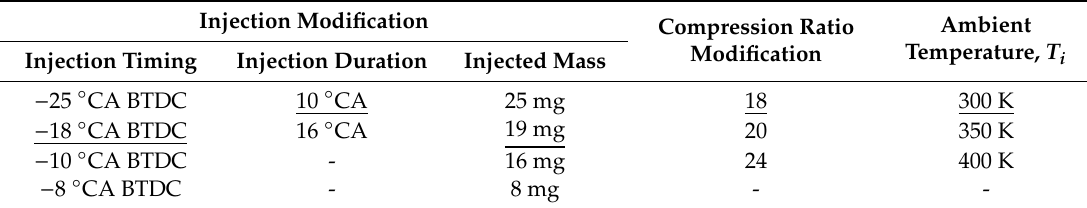
Table 4. Injection system and engine modification